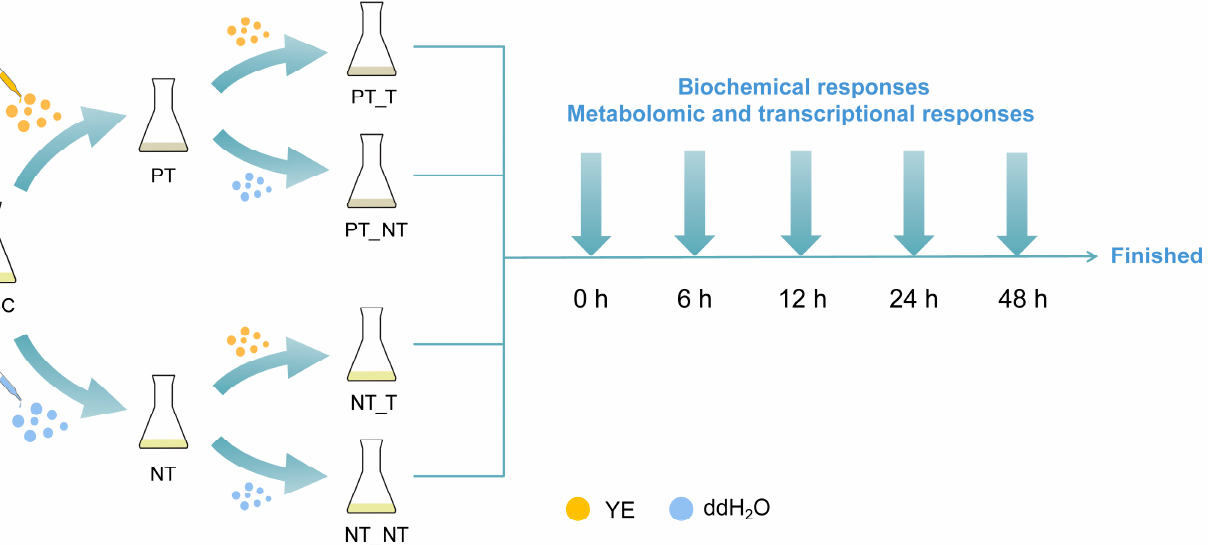
Figure 1. Schematic representation of the experimental design. SPSC, Sorbus pohuashanensis suspen- sion cell; YE, yeast extract; PT, pretreated samples; NT, non-treated samples; T, treated samples; PT_T, pretreated group; PT_NT, resumed group; NT_T, non-pretreated group; NT_NT,